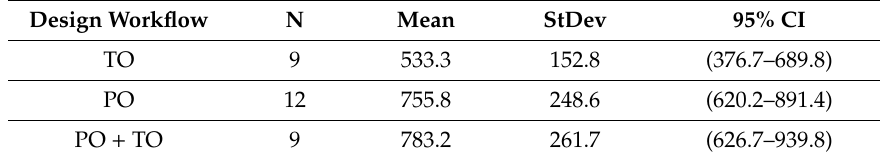
Figure 18. Presentation of the results clustered in the TO, PO, and PO + TO workflows: ( a ) Mass, ( b ) maximum stress, ( c ) optimization time, and ( d ) interval plot for the three case studies. Table 9. The essential statistics of the workflows.